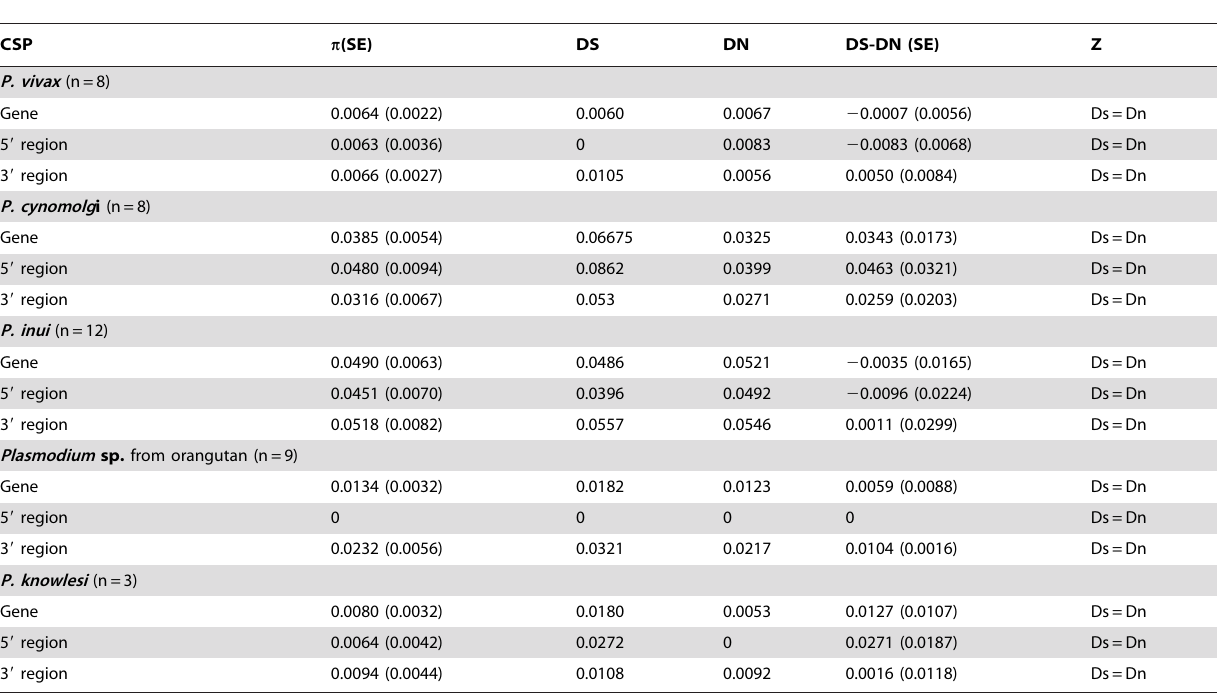
Table 4. Polymorphism found in the CSP gene in different Plasmodium